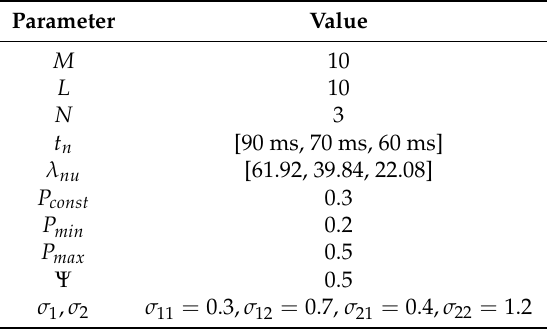
Table 3. Parameters’ setting in the